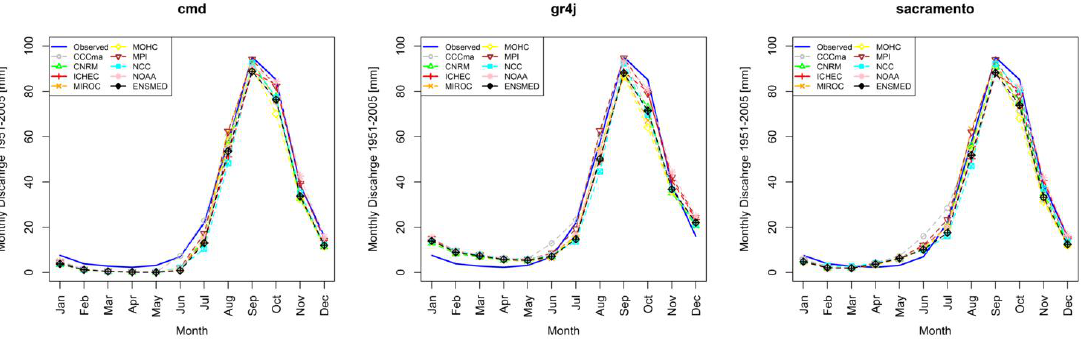
Figure 4. Comparison of historical (1951–2005) mean monthly discharge from eight GCMs and ensemble with the observed discharge for IHACRES-CMD (cmd), GR4J (gr4j) and Sacramento models .